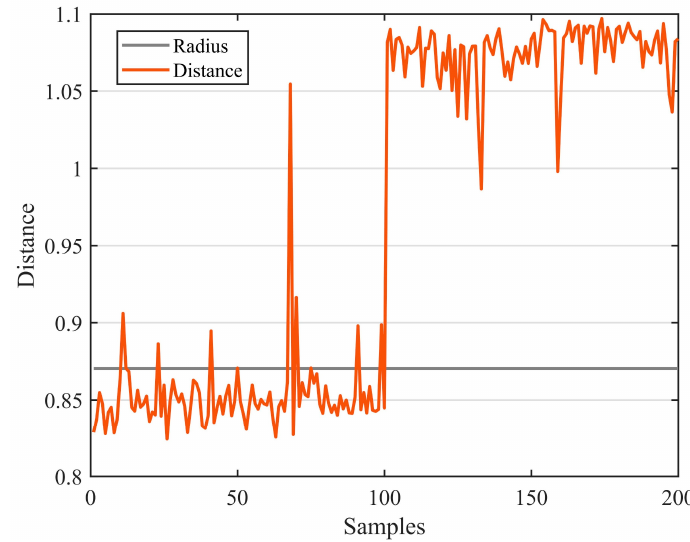
Figure 10. Results of testing.